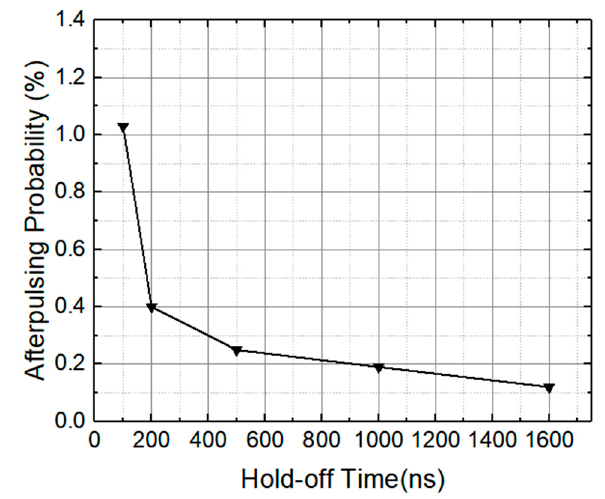
ff erent hold-o ff